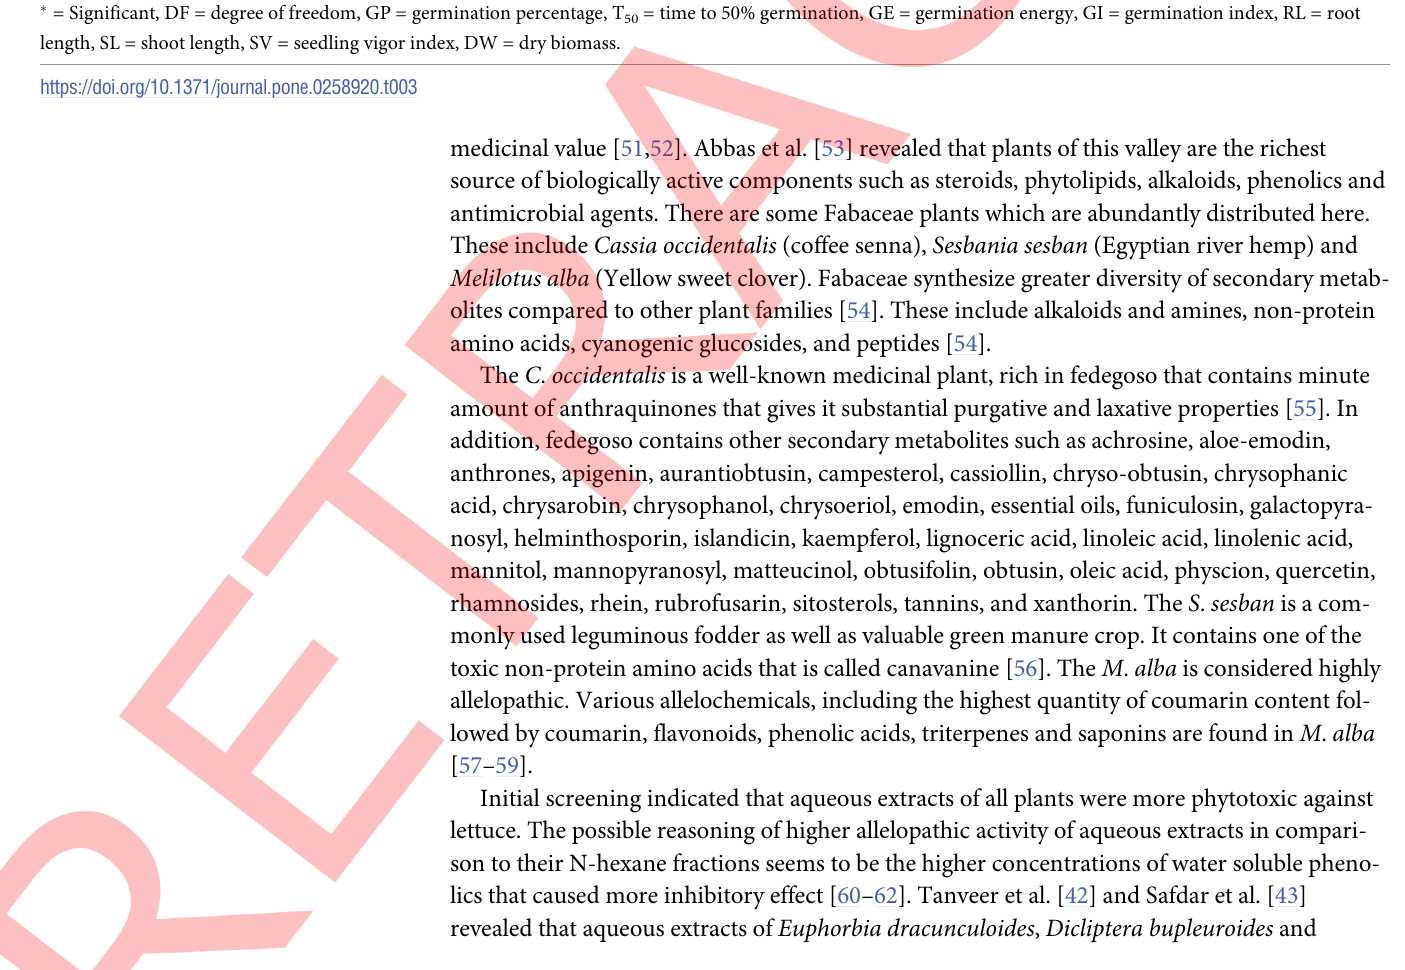
50 = time to 50% germination, GE = germination energy, GI = germination index, RL = root